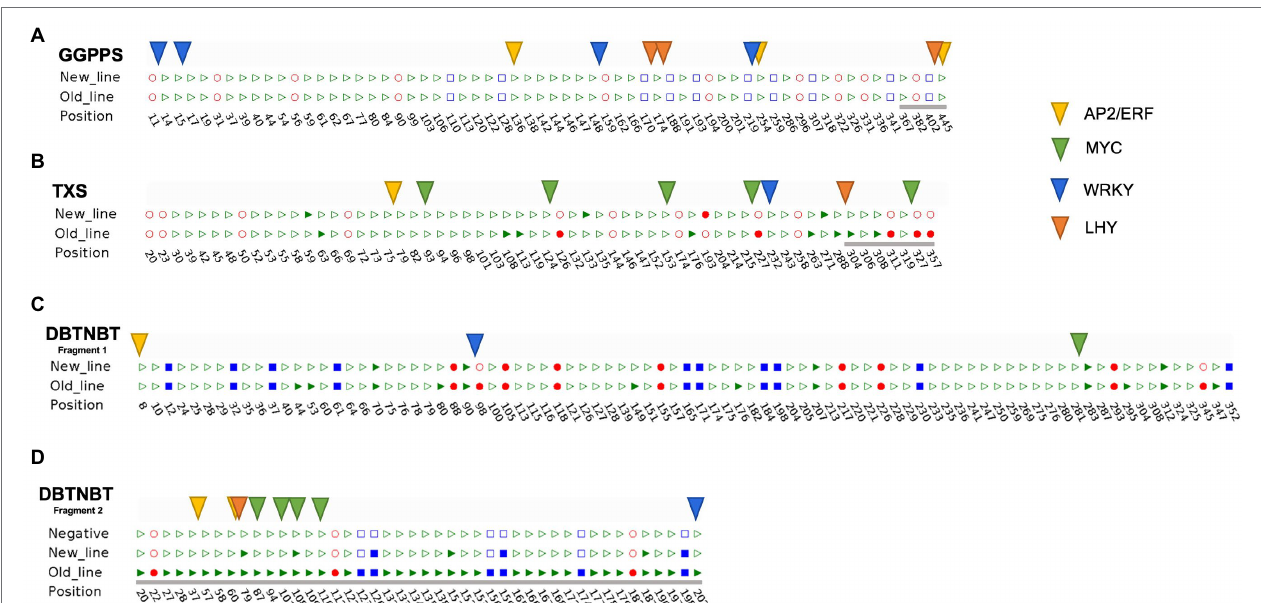
FIGURE 3 | cis -acting regulatory elements involved in defense and stress responsiveness in the partial promoter regions of Taxus x media cell lines. (A) GGPPS partial promoter. (B) TXS partial promoter. (C) DBTNBT promoter region before the TSS, fragment 1. (D) DBTNBT promoter region from the TSS to the initial region of the CDS, fragment 2. The three different cytosine contexts are indicated in red spheres (CG), blue squares (CHG) and green triangles (CHH), colored (methylated) or empty (not methylated). The transcription factors studied are AP2/ERF, MYC, WRKI, and LHY. The distance between the TSS and CDS is highlighted by a gray